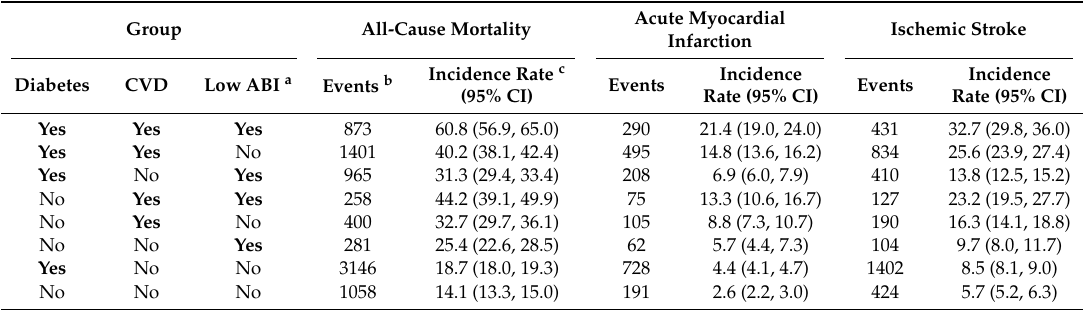
Table 2. Raw incidences of all-cause mortality, acute myocardial infarction, and ischemic stroke by population groups.